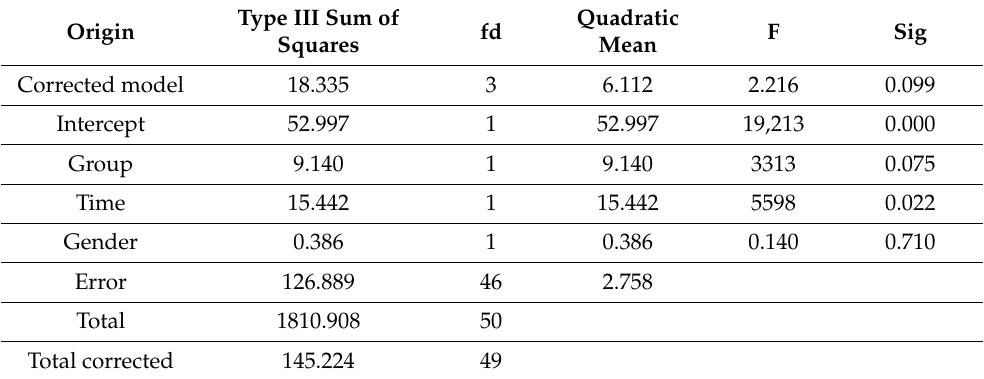
Table 4. Tests for inter-subject